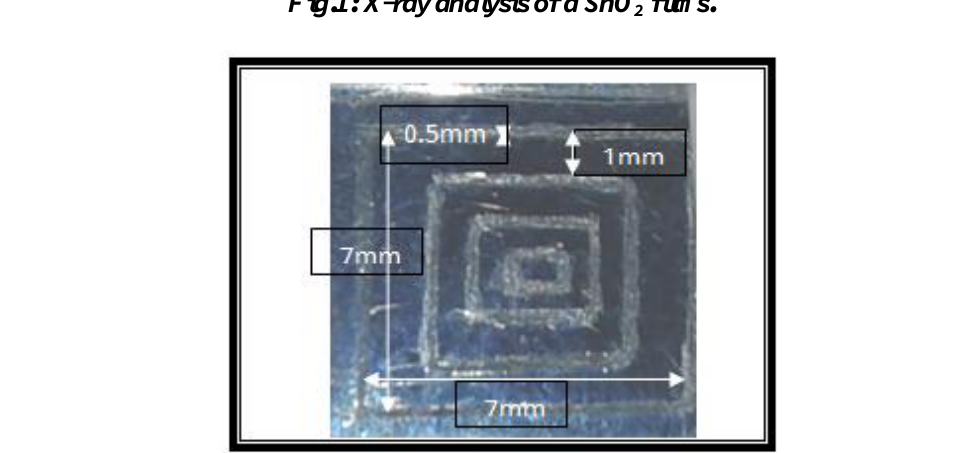
Fig.1: X-ray analysis of a SnO